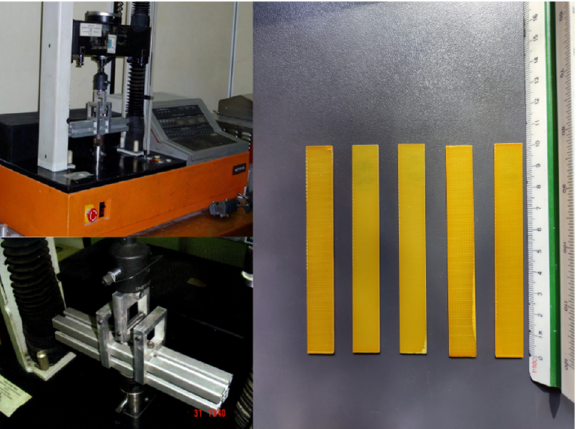
Figure 1. Experimental setup and glass fiber-reinforced